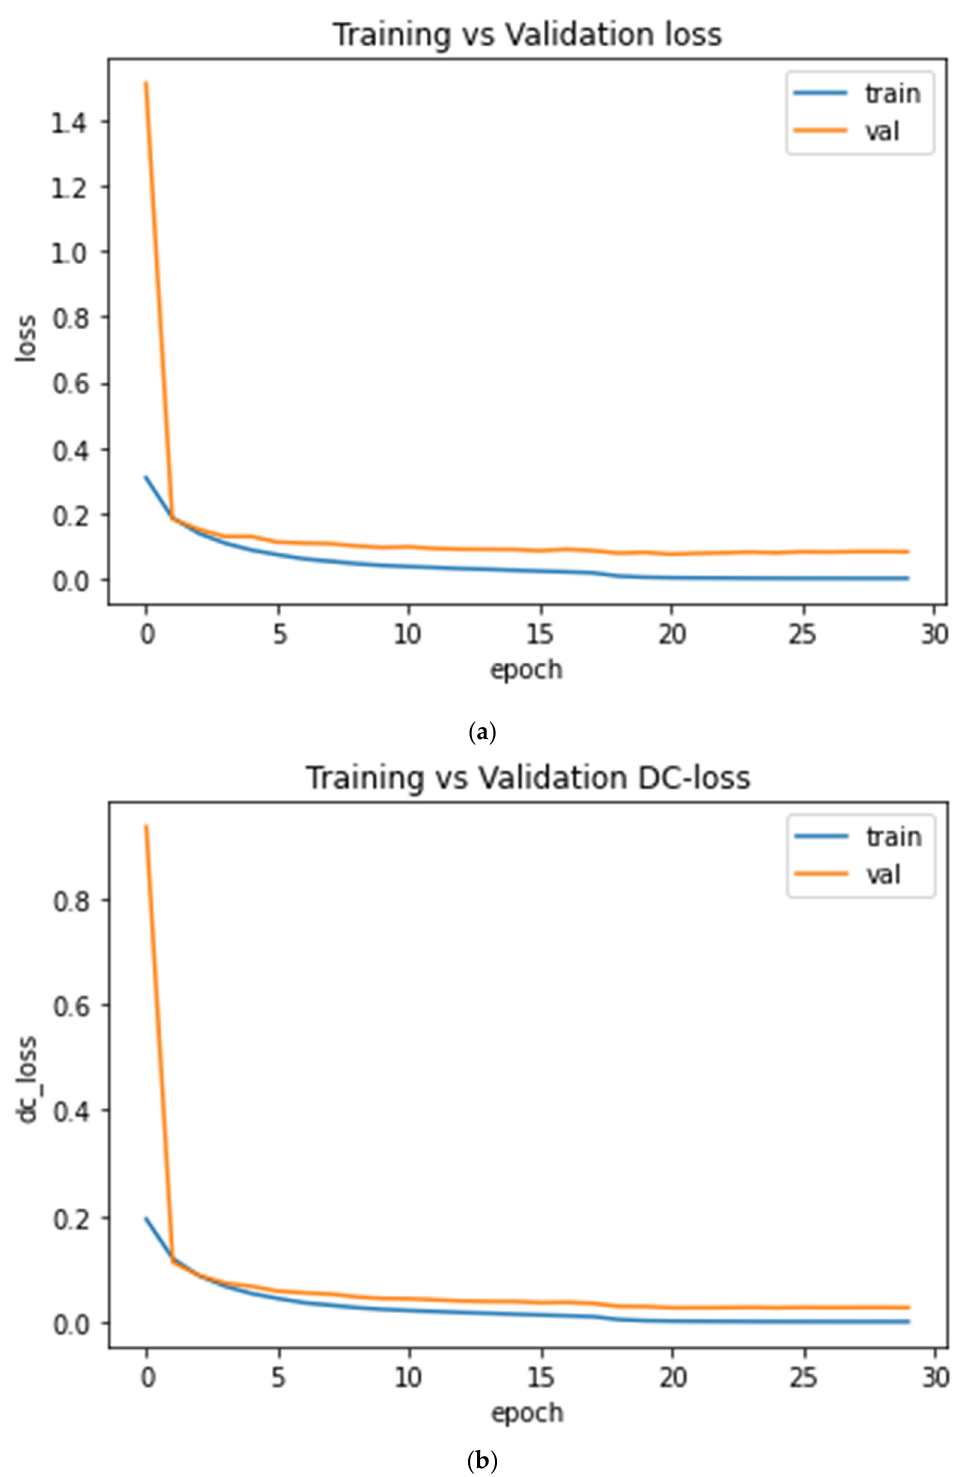
Figure 7. The loss value after 30 epochs training vs. test curves; ( a ) BCE-Dice Loss curve; and ( b ) Dice Similarity Loss curve.